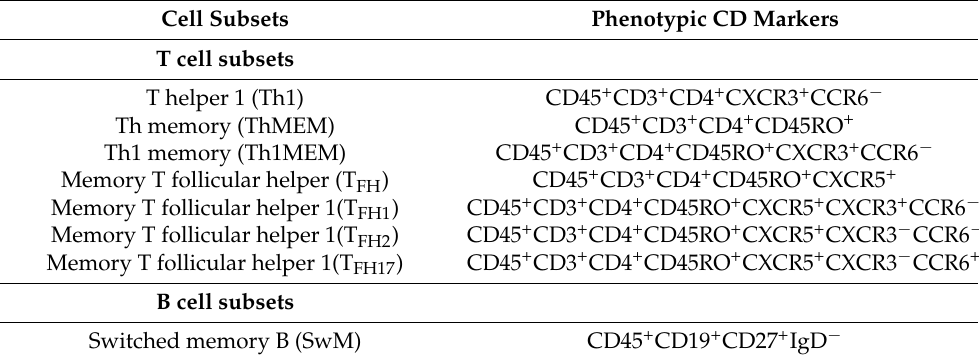
Figure 1. Gating strategy of T and B cell analysis explained in the text. Table 1. Phenotypic characterization of the T and B cell